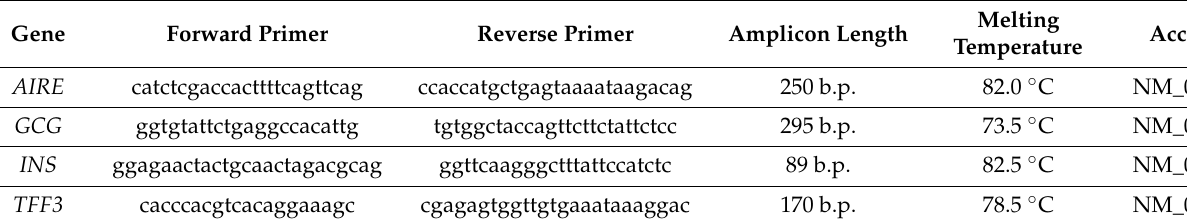
Table 1. Used primers and predicted amplicon characteristics.